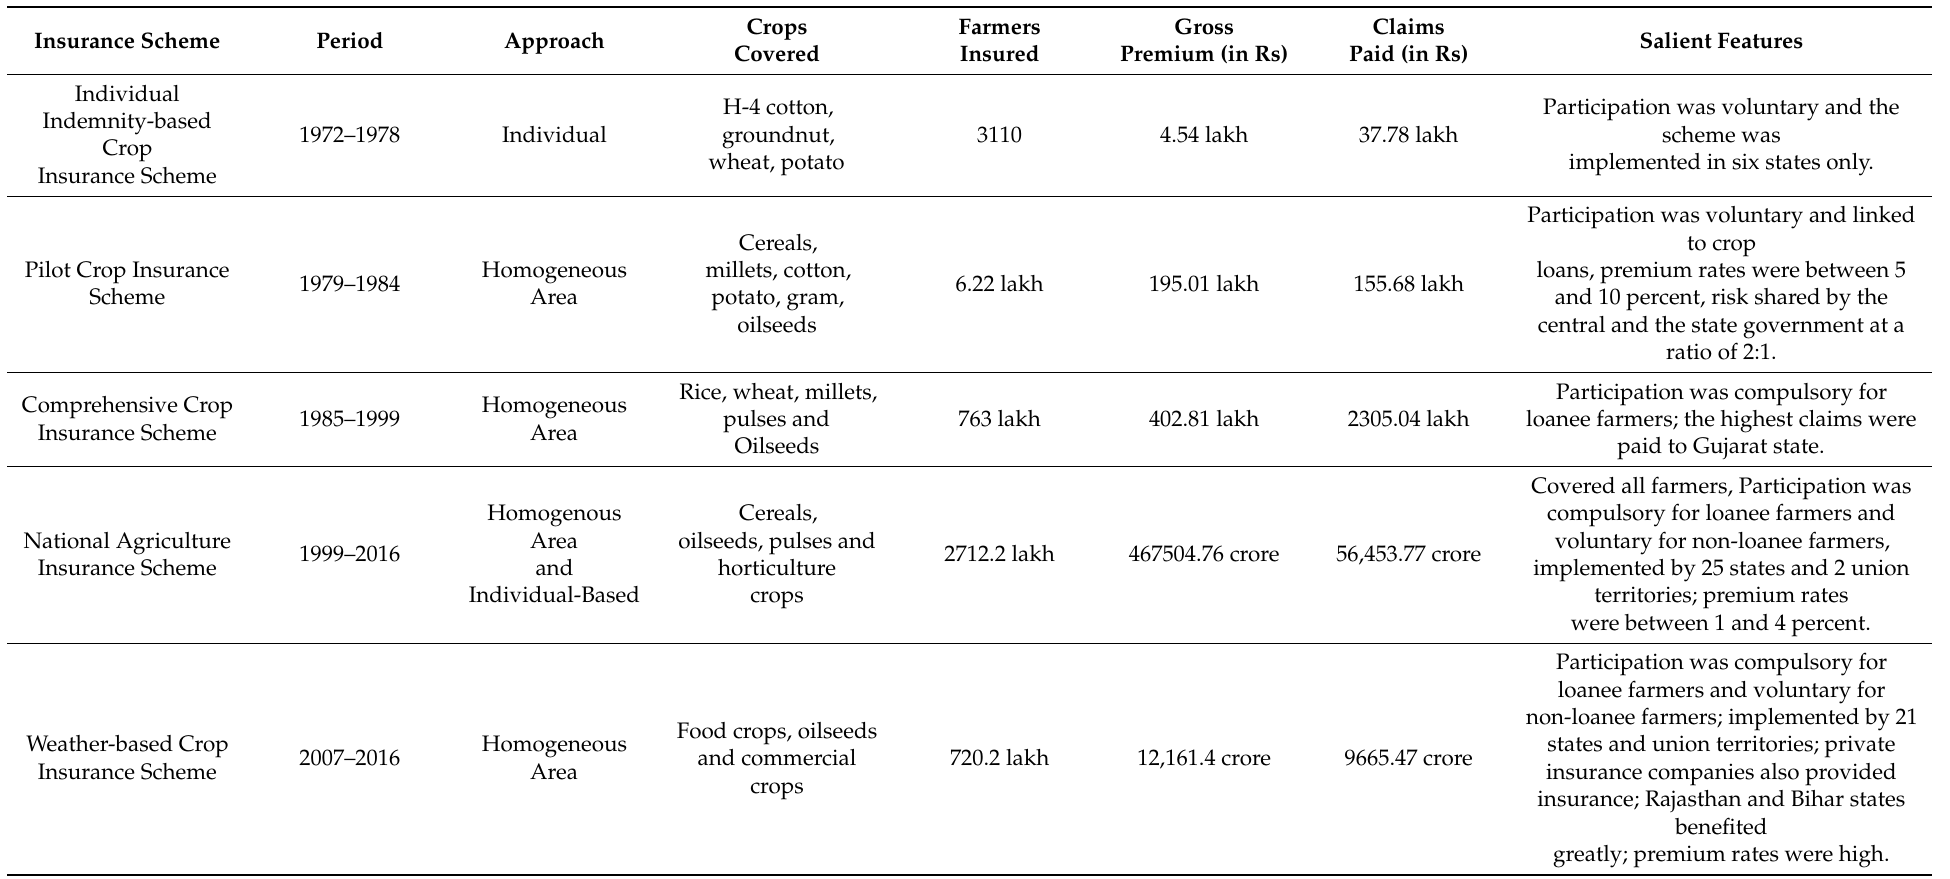
Table 1. Comparison of various crop insurance schemes in